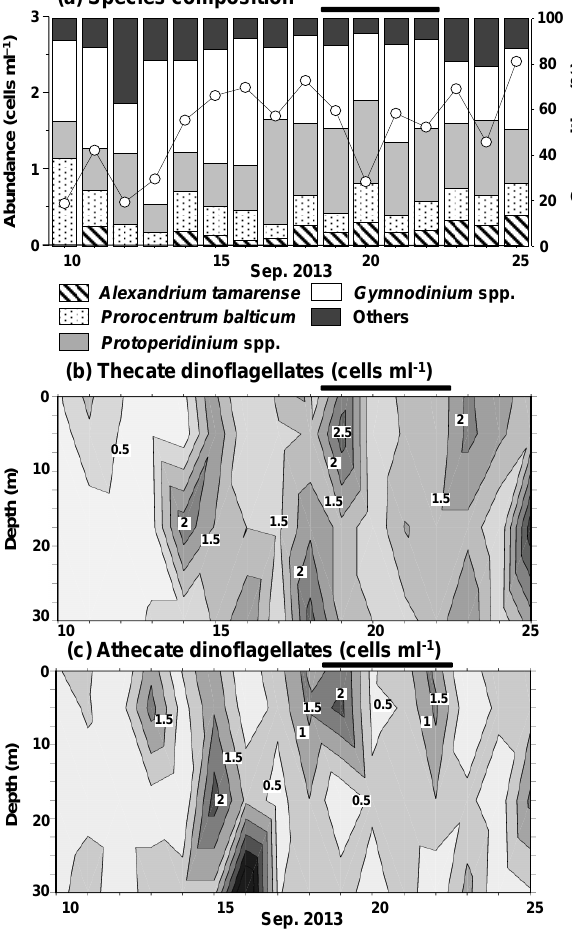
Figure 4. Temporal changes in cell density and species composition of total dinoflagellates (a) , vertical distribution of thecate dinoflag- ellates (cellsmL − 1 ) (b) and athecate dinoflagellates (cellsmL − 1 ) (c) in the Chukchi Sea for the period from 10 to 25 September 2013. In (a) , values represent the mean of dinoflagellate abundance be- tween 0 and 30m. Solid bars indicate the timing of a strong wind